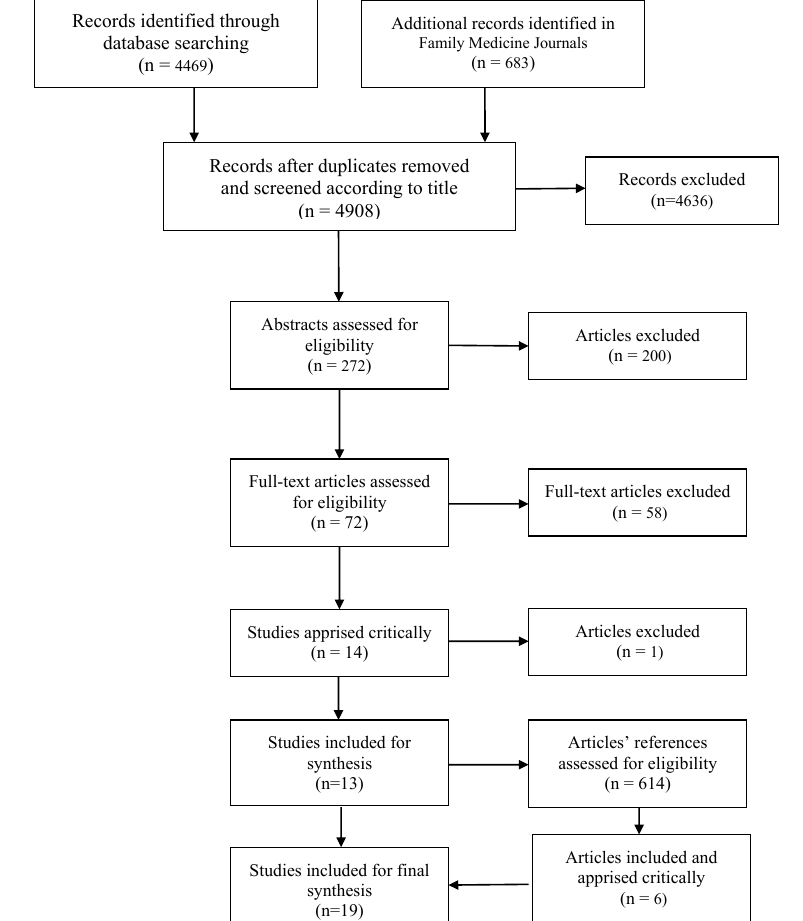
(n = 14 ) Figure 1. PRISMA flow diagram of the